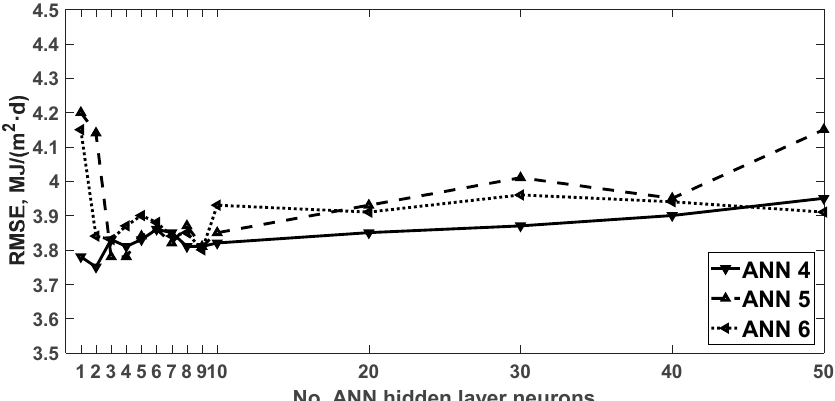
Figure 3. Horizontal daily global solar irradiation effectiveness of prediction the day after simulated with the ANN 4, ANN 5, and ANN 6 models, compared with the variable measured values, in 2011, as a function of the neurons number in the hidden layer.